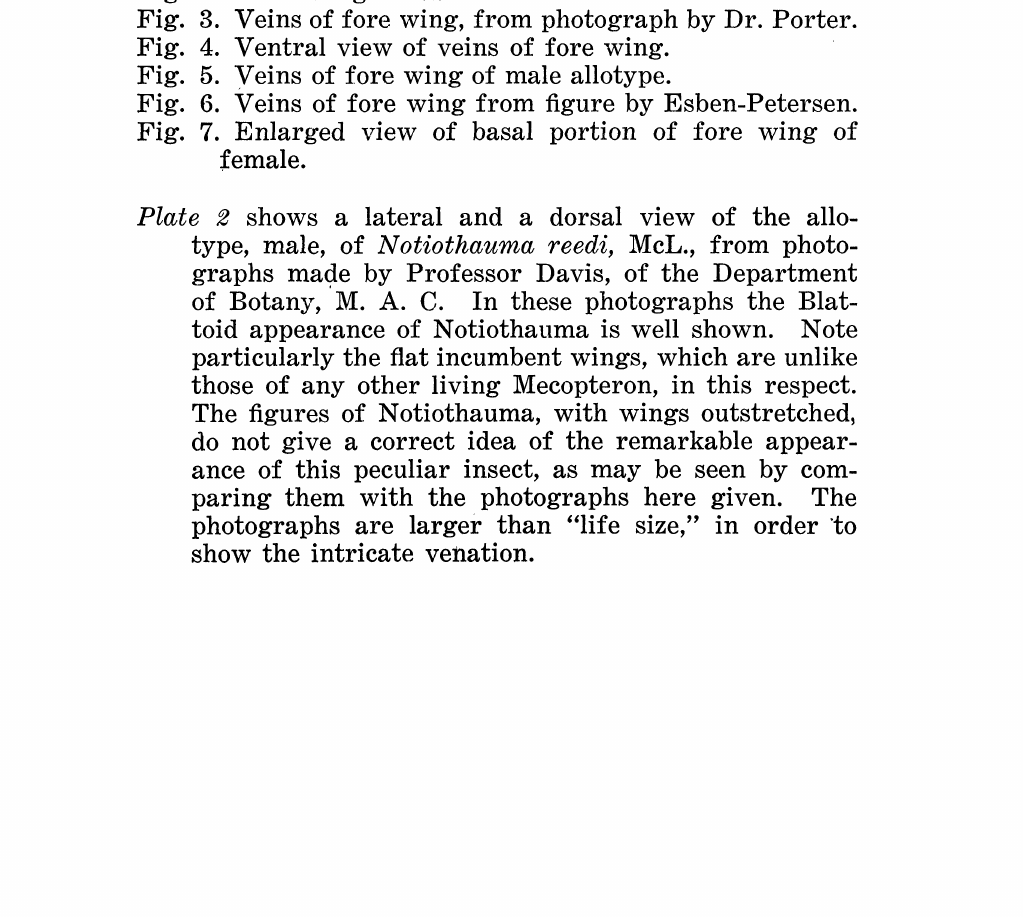
Fig. 1. Fore wing of Notiothauma (female). Fig. 2. Hind wing of same. Fig. 3. Veins of 2ore wing, from photograph by Dr. Porter. ore wing. Fig. 4. Ventral view of veins of Fig. 5. Veins of fore wing of male allotype. ore Fig. 6. Veins of wing from figure by Esben-Petersen. Fig. 7. Enlarged view of basal portion of fore wing of